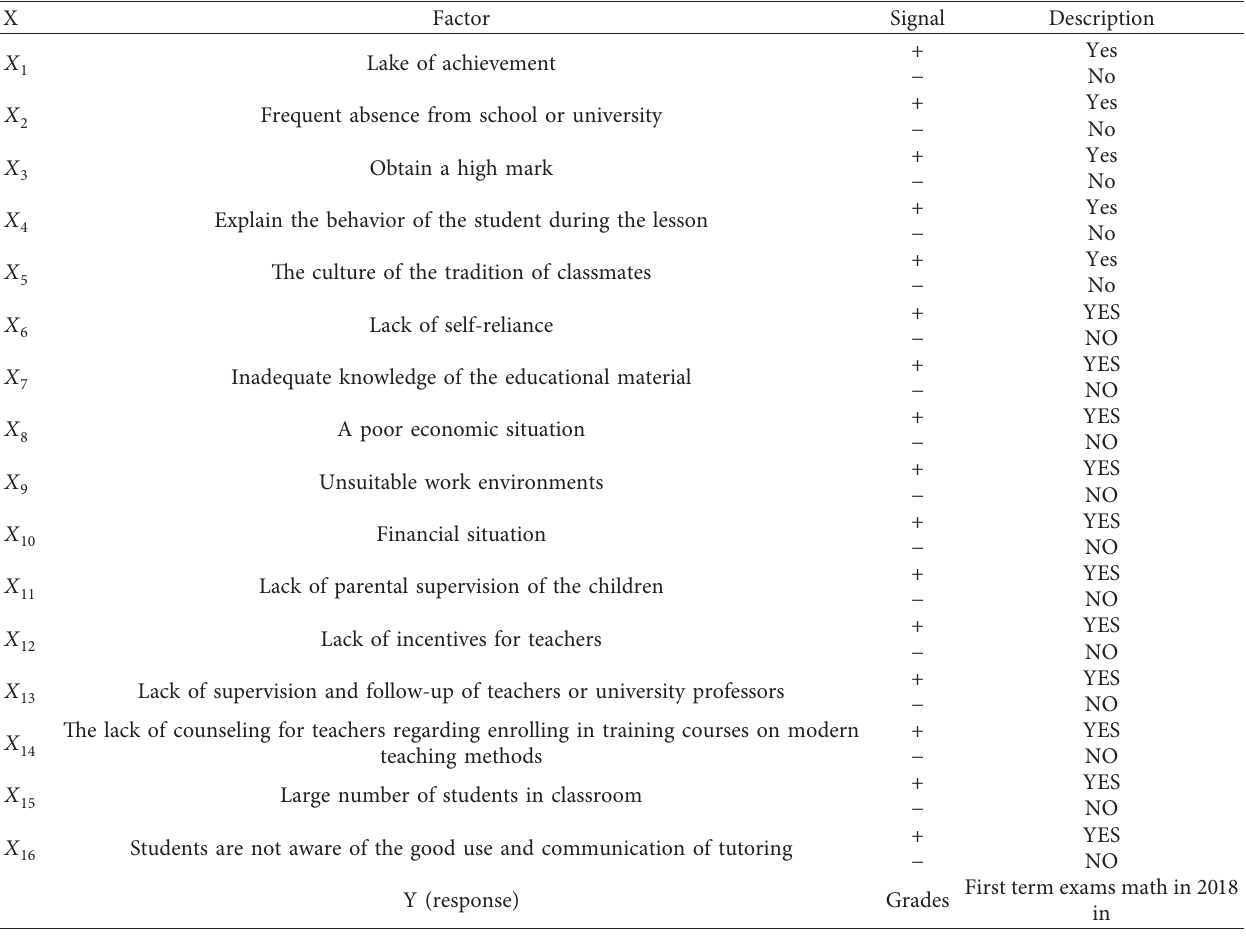
Table 1: Notes to be considered about the data